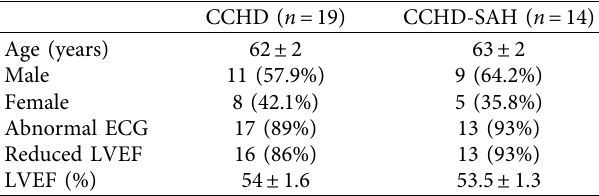
Table 1: Clinical characteristics of Chagas disease patients enrolled in the